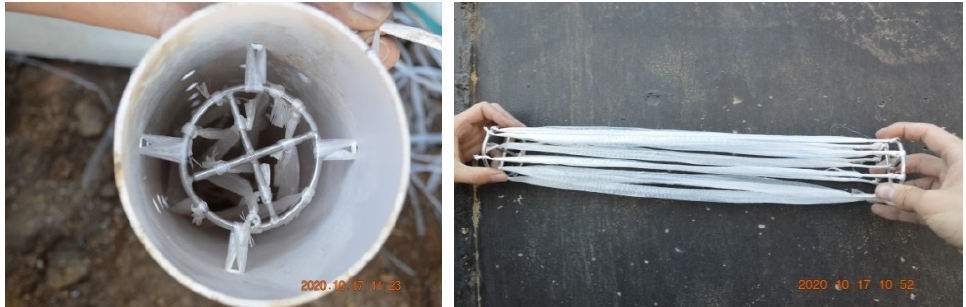
Figure 26. The arrangement of the fiber bundle in the drainage pipe.